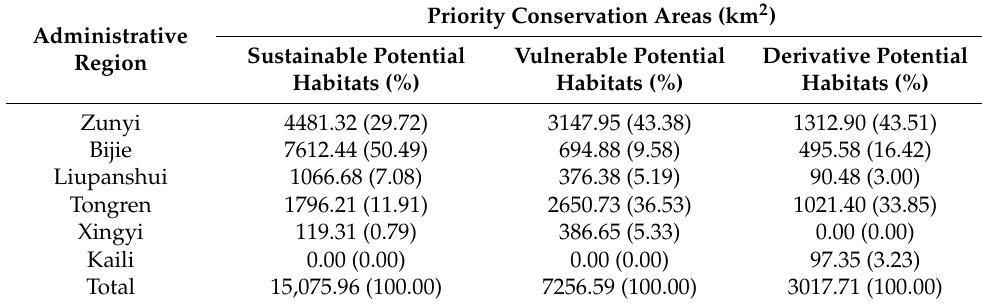
Figure 3. Priority conservation areas under climate change. Table 2. Statistics of priority conservation areas under climate